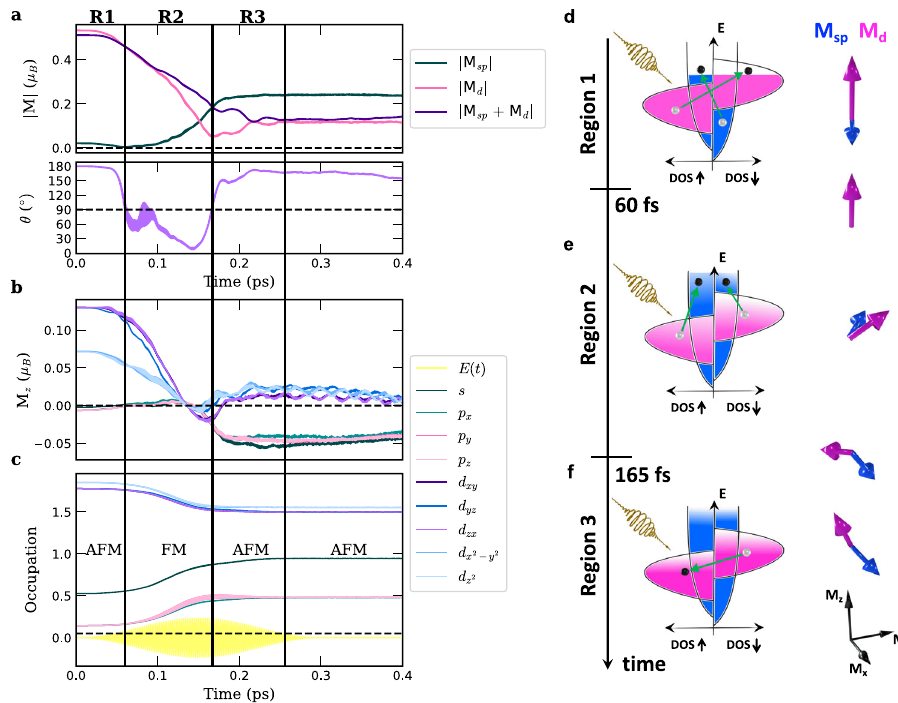
Fig. 5 Orbital dependence of the ultrafast magnetization dynamics of bulk Ni. a The length of the magnetization vectors for the sp and d orbitals along with their vector sum and the angle θ between the magnetization vectors of the sp and d orbitals. b The orbital contributions to the z component of the magnetization. c The occupation of the sp and d orbitals. The vertical lines indicate the identi fi ed three regimes of demagnetization. d – f Schematics of the magnetization dynamics for the different regimes. The diagrams on the left column indicate the main electronic processes while those on the right illustrate the evolution of the noncollinear intra-atomic magnetic moments. In this simulation, the width of the laser pulse was 300 fs and its intensity E = 9.7 × 10 9 V m − 1 0